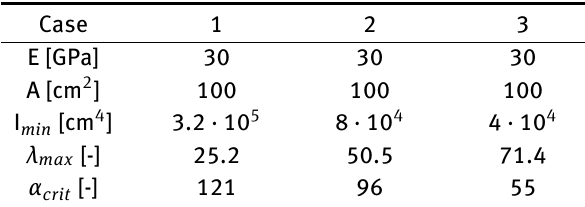
Table 1: Eight-member lattice structure